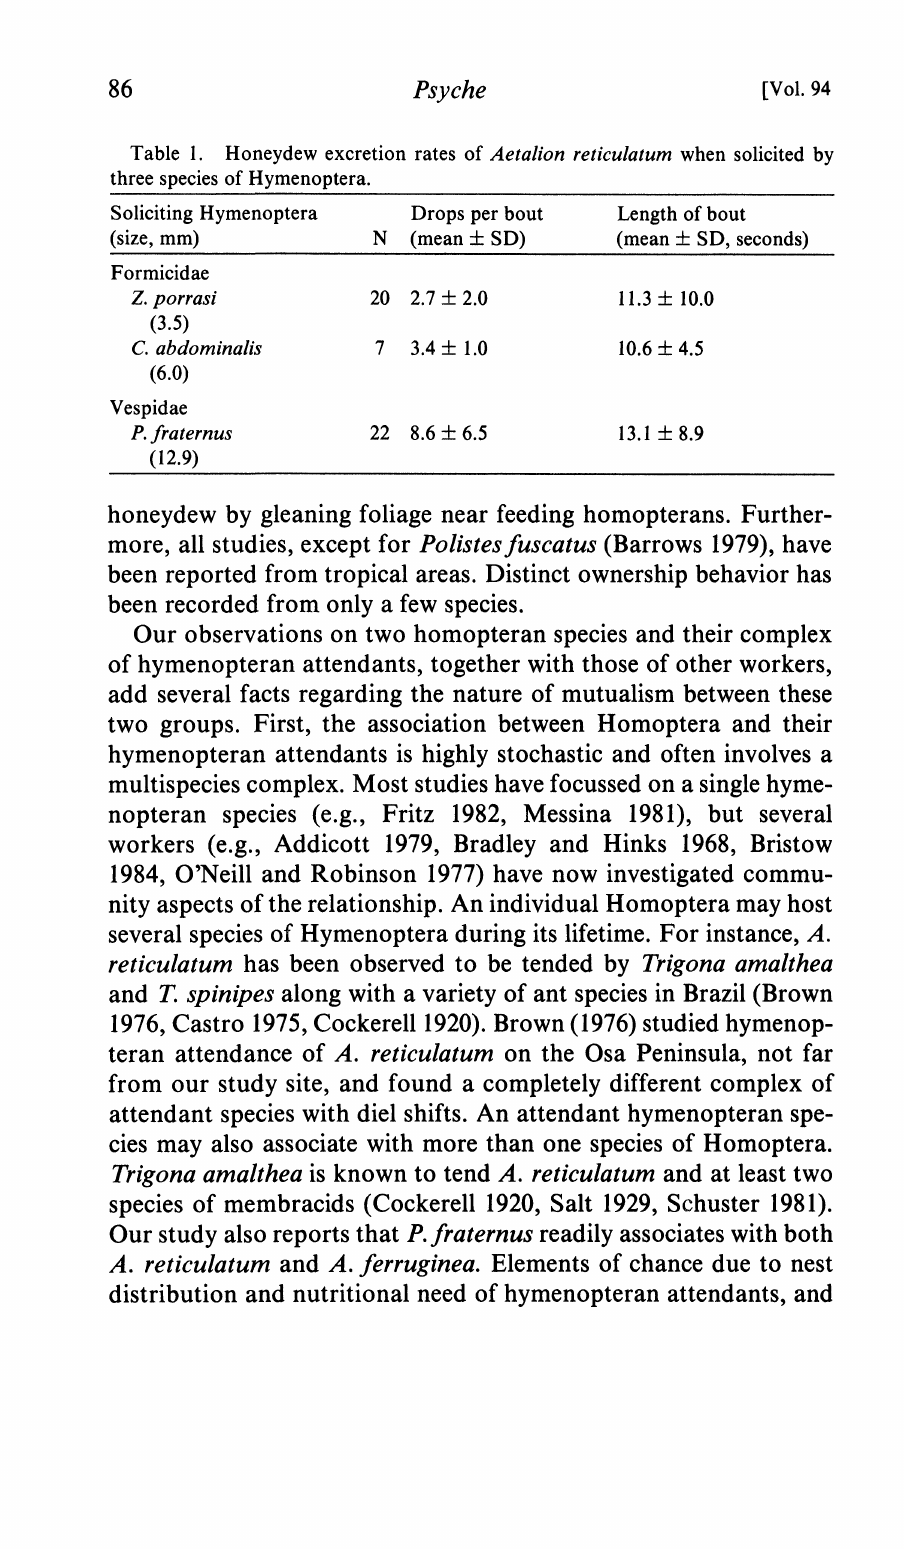
Table 1. Honeydew excretion rates of Aetalion reticulatum when solicited by three species of Hymenoptera. Soliciting Hymenoptera (size, mm) Formicidae Z.